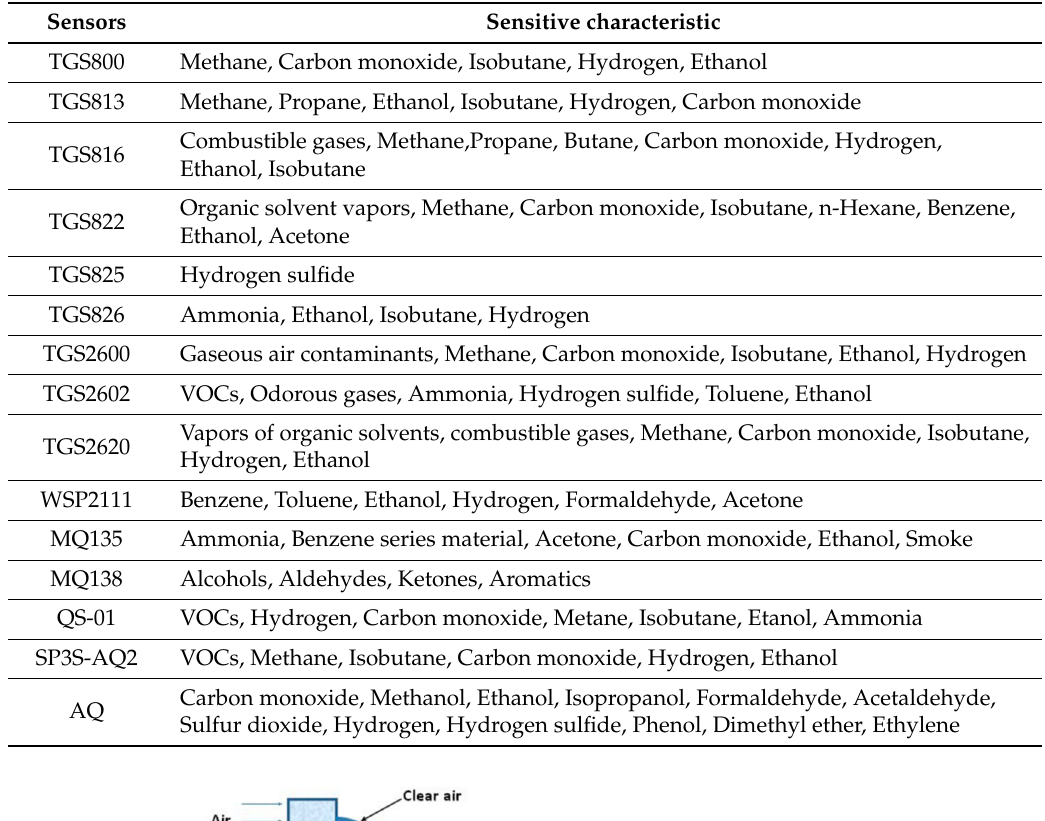
Table 2. Sensitive characteristic of gas sensors.